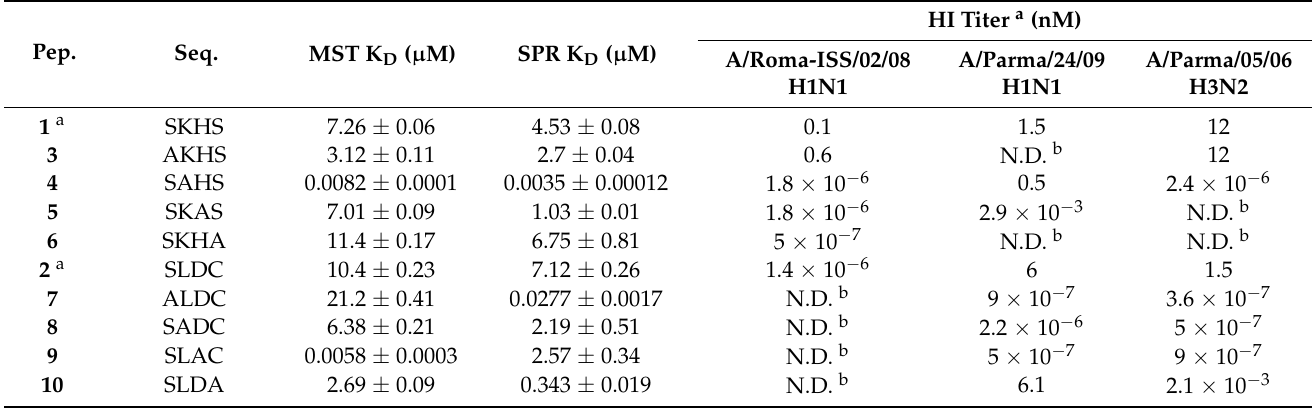
Table 1. Structure characterization, affinity and activity of peptides 1 – 10 . The HI activity of peptides 1 and 2 is reported as a reference. a Scala et al. (2017) [14]. All peptides are amidated and acetylated. a The HI titer, determined by the hemagglutination inhibition assay, corresponds to the concentration of the peptide that produces 50% inhibition of virus- induced hemagglutination, i.e., IC50. b N.D.: not detectable at the maximum tested concentration (12.5 × 10 3 nM).